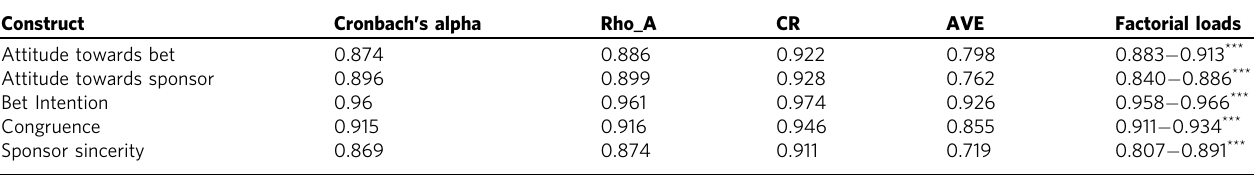
Table 3 Evaluation of the measurement model: CR — composite reliability.